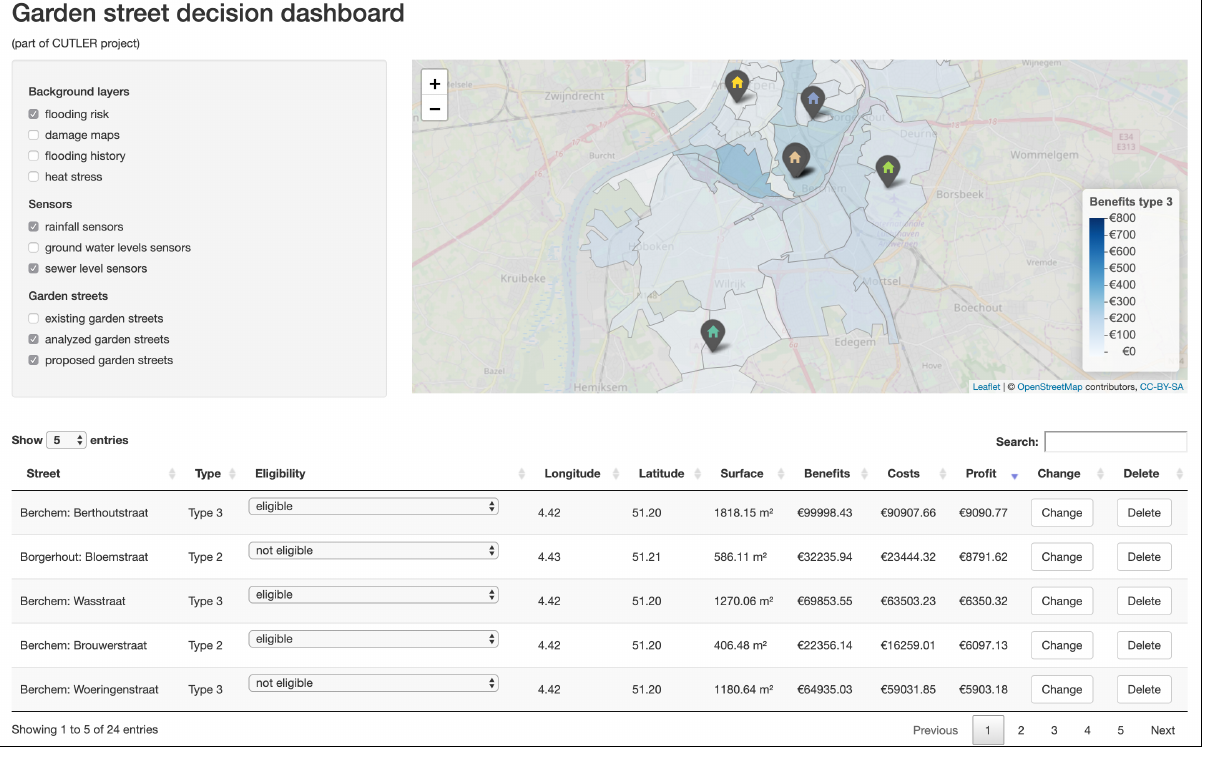
Figure 3. A wireframe for the Antwerp input evaluation dashboard was created. It includes (a) a data table at the bottom with the garden street proposals that can be ordered by profit, (b) a selection frame at the left for selecting and deselecting information layers to evaluate the garden street proposals, and (c) an interactive map showing the information layers, the information points and the location of (proposed) garden streets.